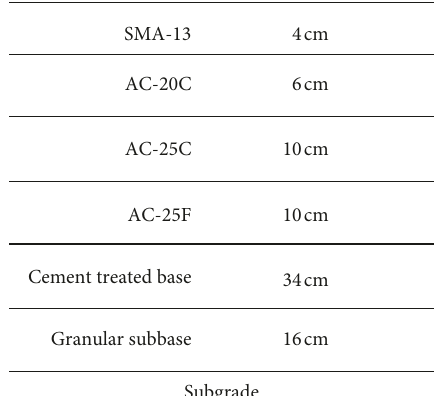
Figure 1: Test road pavement structure I.